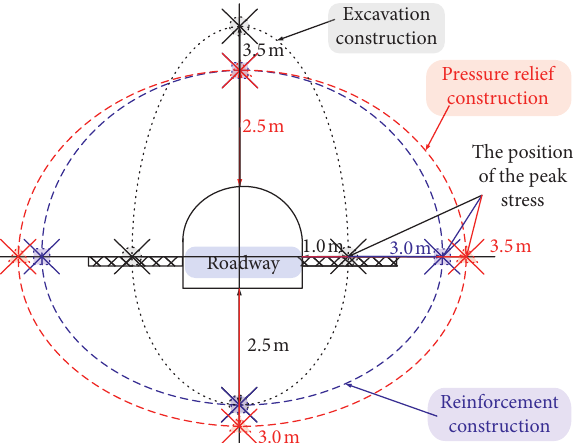
Figure 16: Distribution of principal stress difference peaks of roadway surrounding rocks.